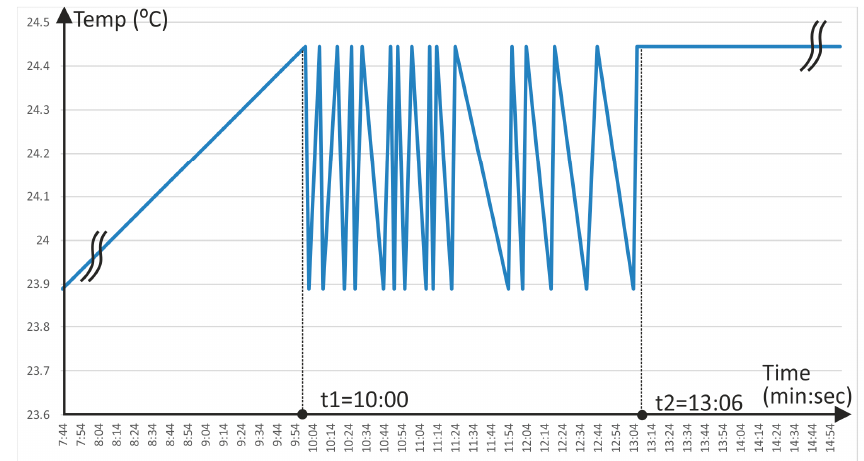
Figure 8. Temperature oscillation as logged by a dive computer (Hollis TX1).